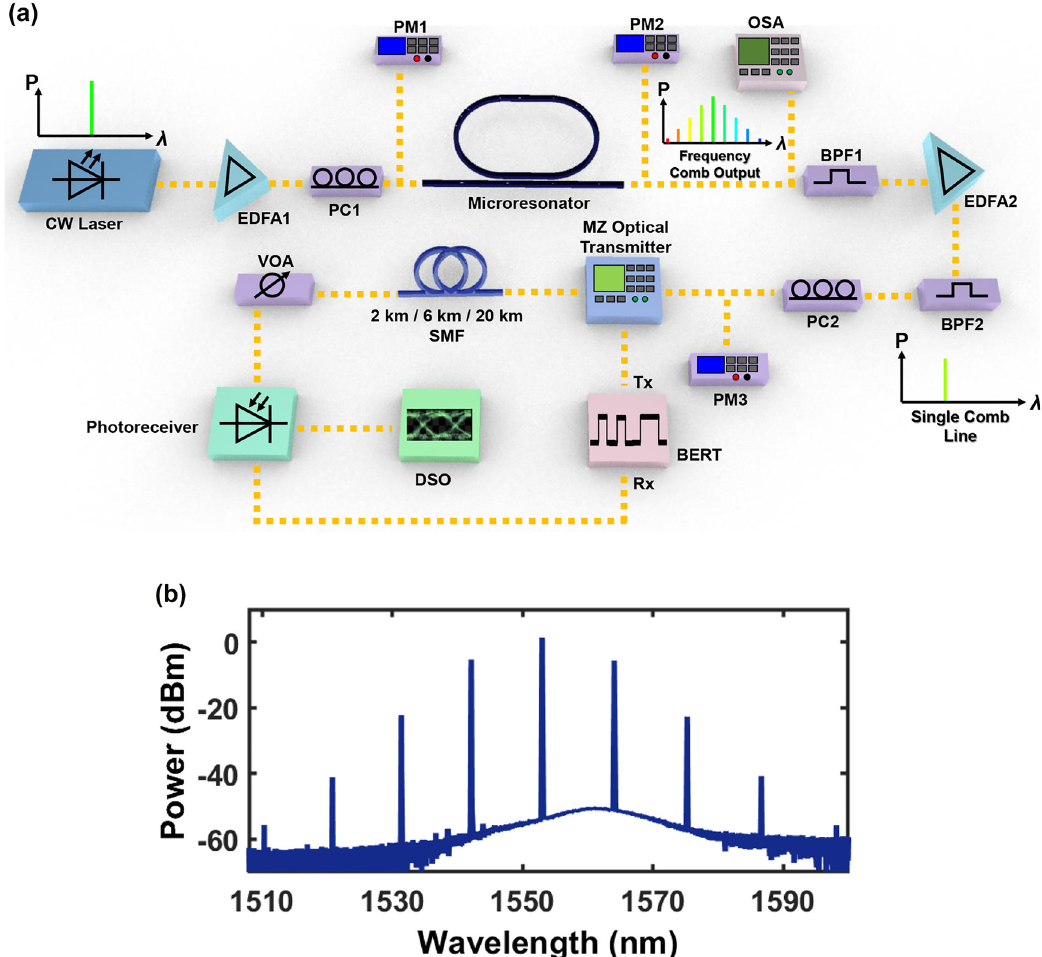
Figure 4: Experimental setup and frequency comb state used for the high-speed data experiments. (a) Schematic of the IMDD high-speed data experiments using the microresonator frequency comb. (b) Spectrum of the comb state used for the high-speed data experiments. The pump wavelength and power are 1553 nm and 20 mW respectively. EDFA – Erbium Doped Fiber Amplifier, PC – Polarization Controller, PM – Power Meter, BPF – Bandpass Filter, OSA – Optical Spectrum Analyzer, MZ – Mach Zehnder Transmitter, DSO – Digital Sampling Oscilloscope, BERT – Bit Error Rate Tester, Tx (Rx) – Transmit (Receive) port, VOA – Variable Optical